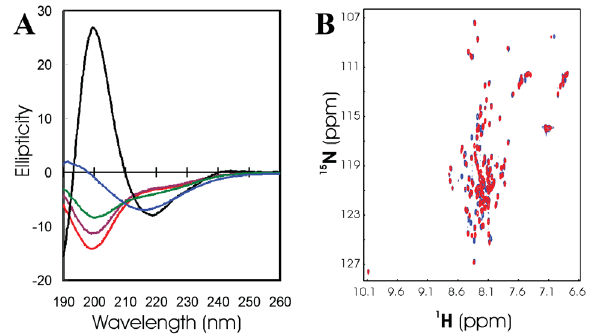
Figure 14. Conformational properties of the P12S-MSP domain. ( A ) Far-UV CD spectra of the wild-type MSP (black) and P12S mutant in unsalted water at pH 3.5 (red), 4.5 (brown), 5.5 (green), and 6.5 (blue). ( B ) Superimposition of HSQC spectra of P56S (blue) and P12S mutants in unsalted water at pH 3.5